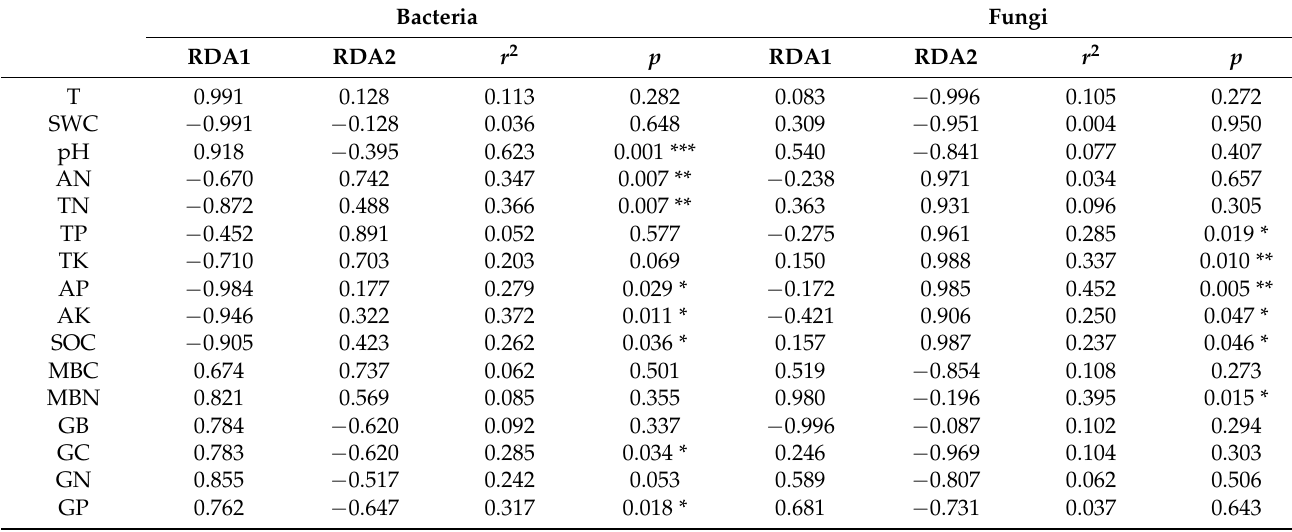
Table 3. RDA and soil and cover grass properties correlated with the soil microbial communities at the genus level. Bacteria Fungi